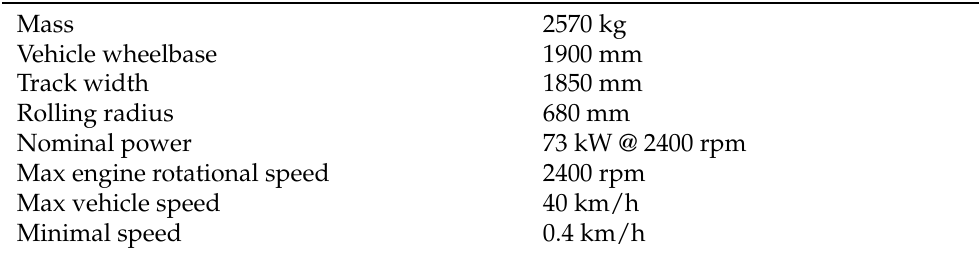
Table 1. Main orchard-tractor characteristics.